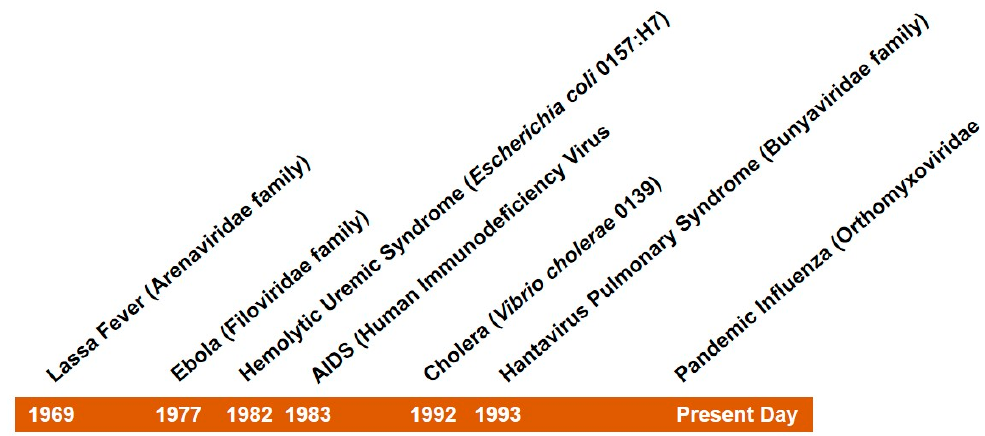
Figure 1. Emerging infectious diseases of the past fifty years.